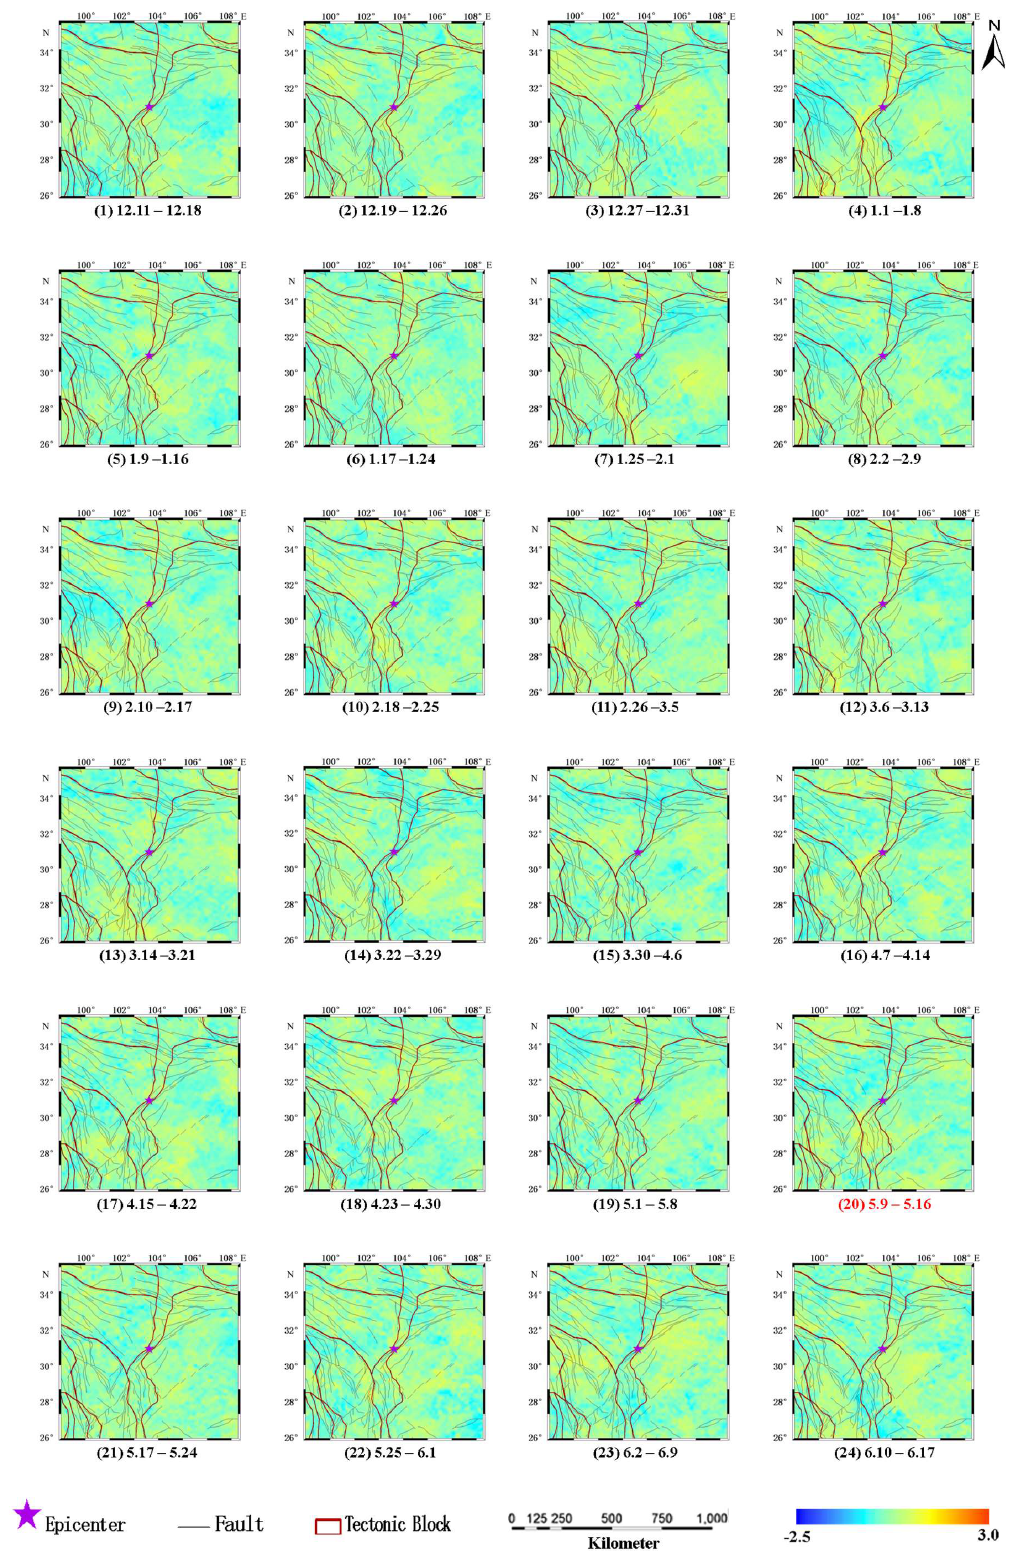
Figure 14. Spatio-temporal evolution of K tec extracted by the TTIA method in the Longmenshan fault region in unperturbed period. The pixels values in images are the mean values of K tec in the same time-slot of unperturbed